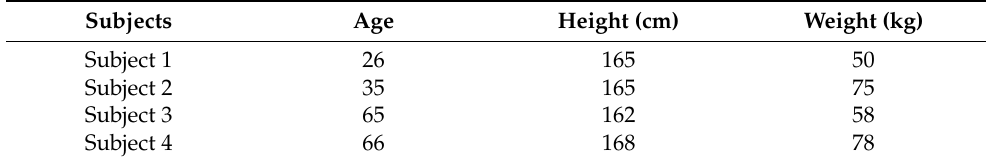
Table 2. A summary of subjects’